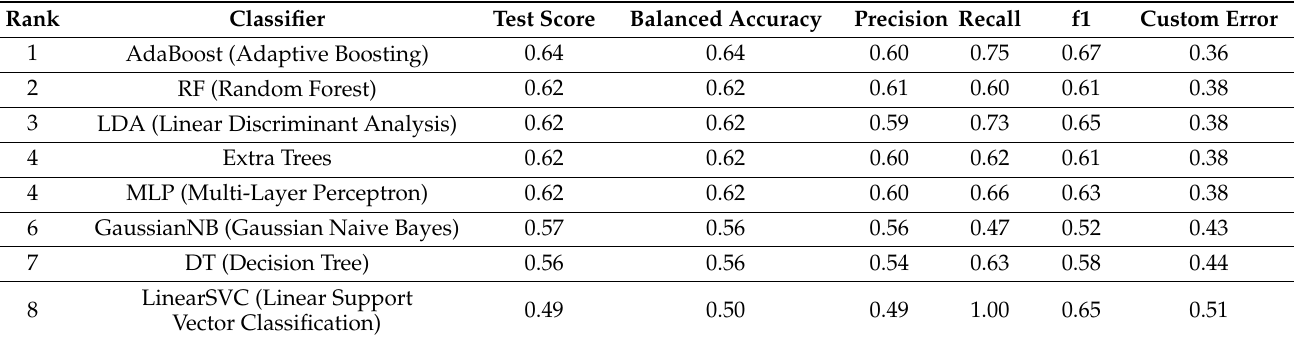
Table 3. Auto-Sklearn metric